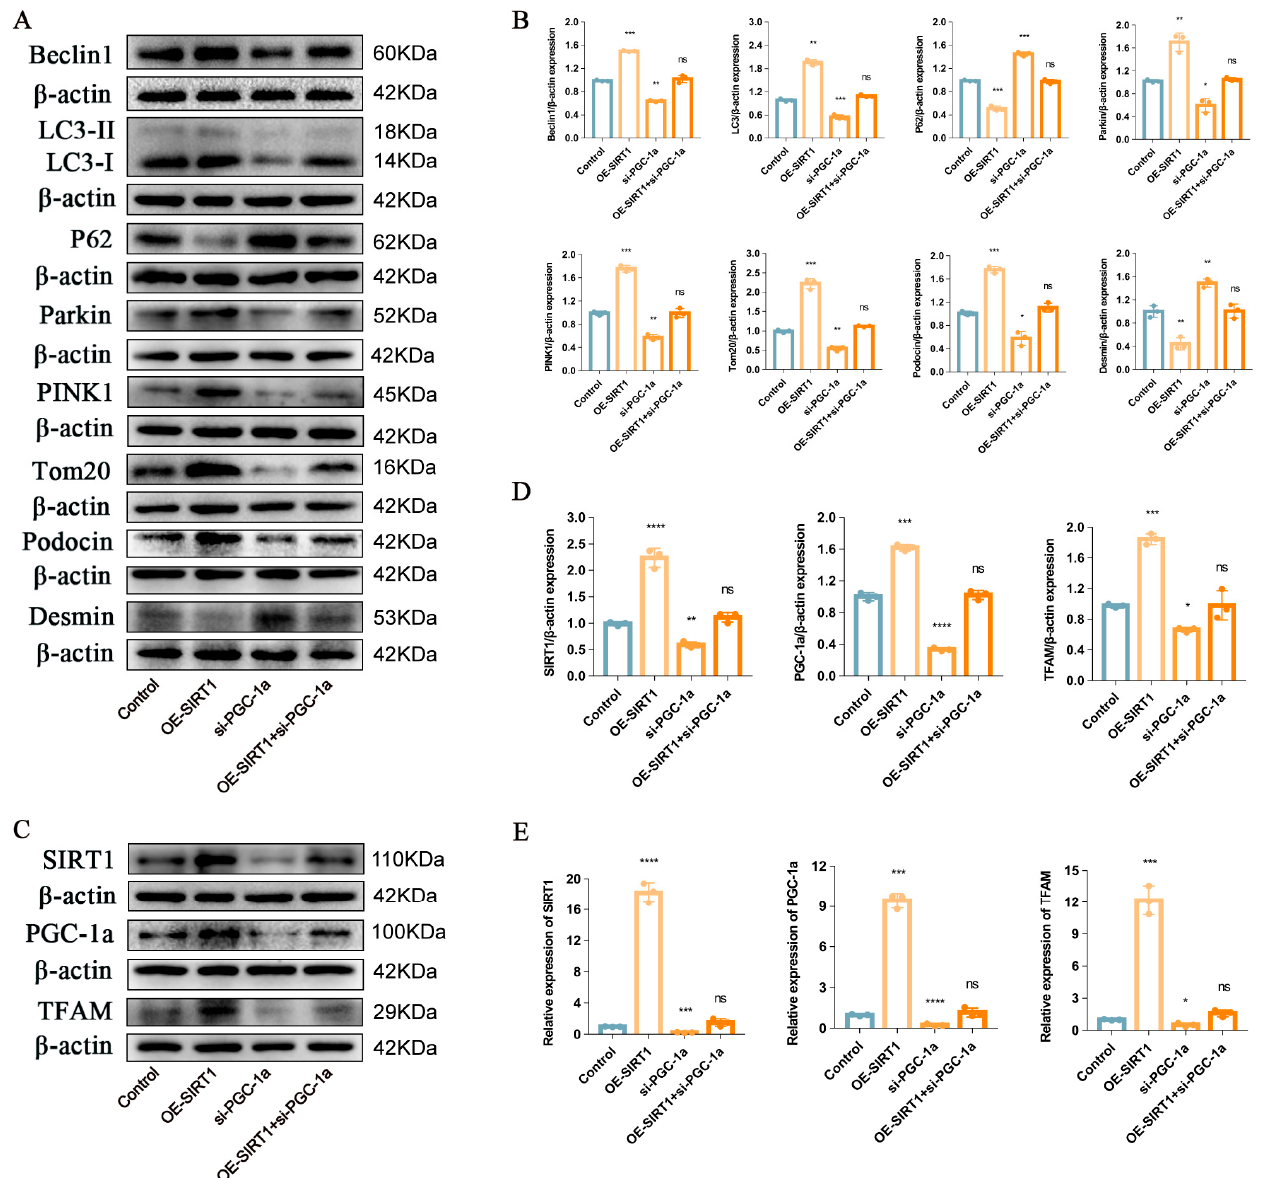
Figure 7. Overexpression of SIRT1 and inhibition of PGC-1a expression were performed (rescue experiments). ( A , B ) Representative Western blot analysis of Beclin1, LC3II/LC3I ratio, P62, Parkin, PINK1, and Tom20, as well as Podocin and Desmin in MPC5. ( C , D ) Representative Western blot analysis of SIRT1, PGC-1a, and TFAM in MPC5. ( E ) Representative RT-PCR analysis of SIRT1, PGC-1a, and TFAM in MPC5. n = 3 for ( A – E ). β -actin was used as loading control. * p < 0.05, ** p < 0.01, *** p < 0.001, and **** p < 0.0001 vs. control; ns = not